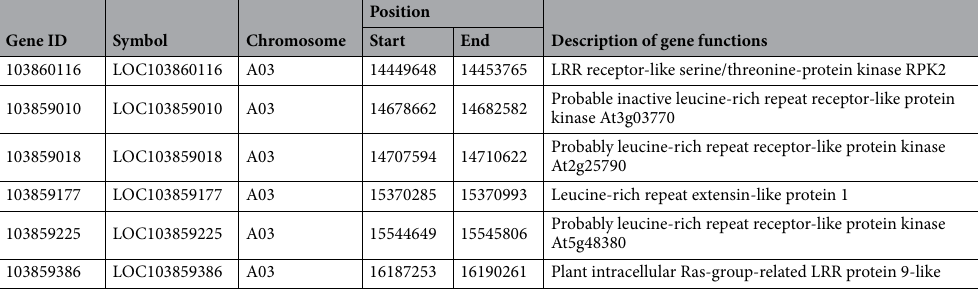
Table 6. List of leucine rich-repeat (LRR) receptor-like kinases in the QTL genomic region associated with resistance to Plasmodiophora brassicae pathotypes 2F, 3H, 5I, 2B, 3D, 5G, 8E, 3O and